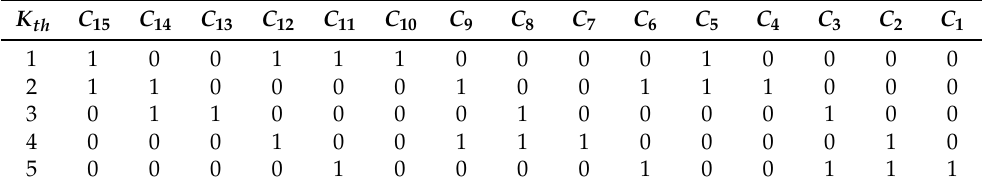
Table 3. Basic EDW code sequence For W = 5